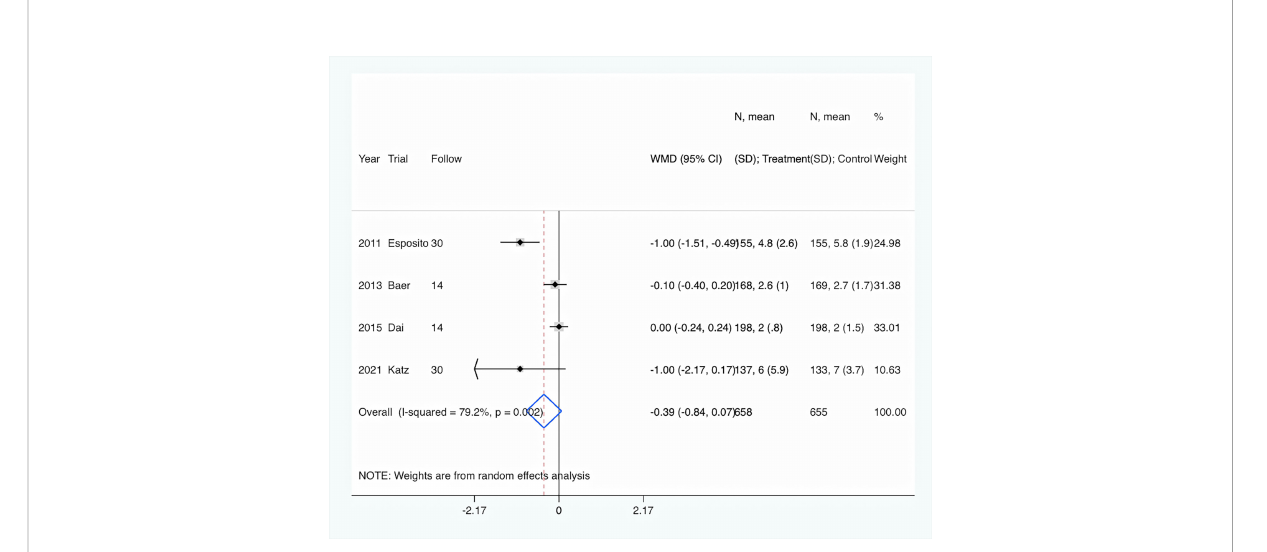
FIGURE 4 PCT-guided treatment was associated with similar length of hospital